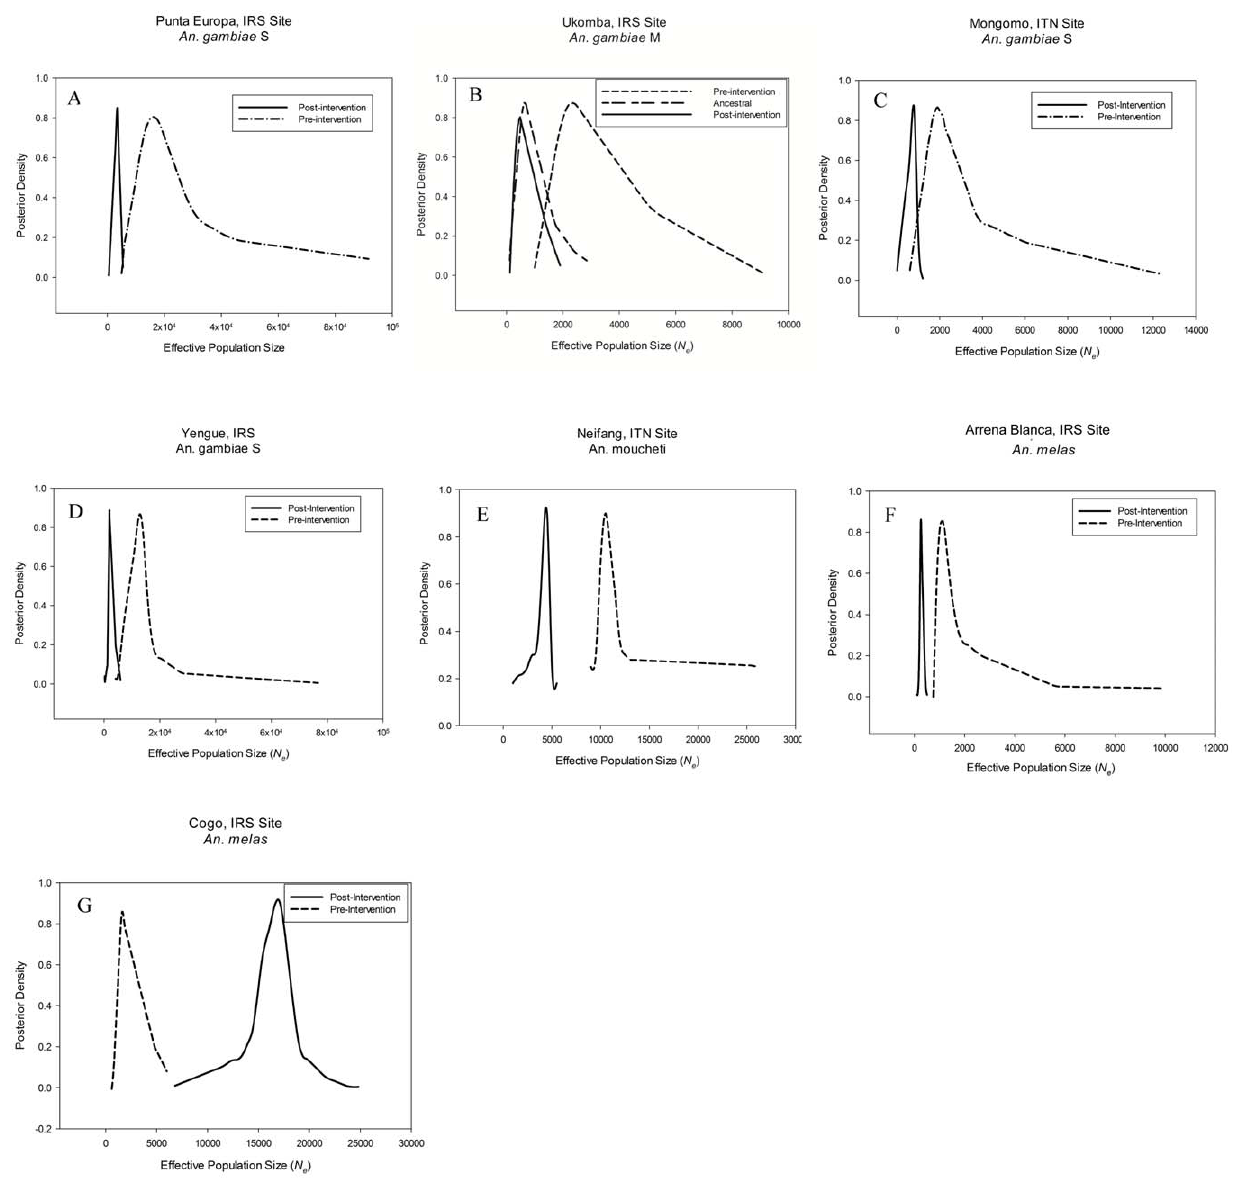
Figure 2. Density plots of effective population size estimates. Posterior density plots of estimated N e from ABC analysis for the seven study populations A) Punta Europa, B) Ukomba, C) Mongomo, D)Yengue, E) Niefang, F) Arena Blanca and G) Cogo. Solid line depicts the post-intervention N e , whereas the dashed line corresponds to the pre-intervention N e .